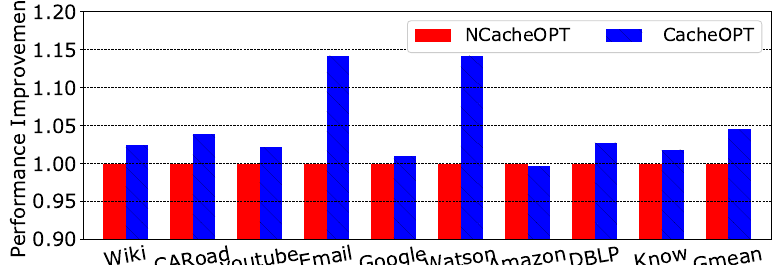
Figure 11. Comparison of the performance with/without cache